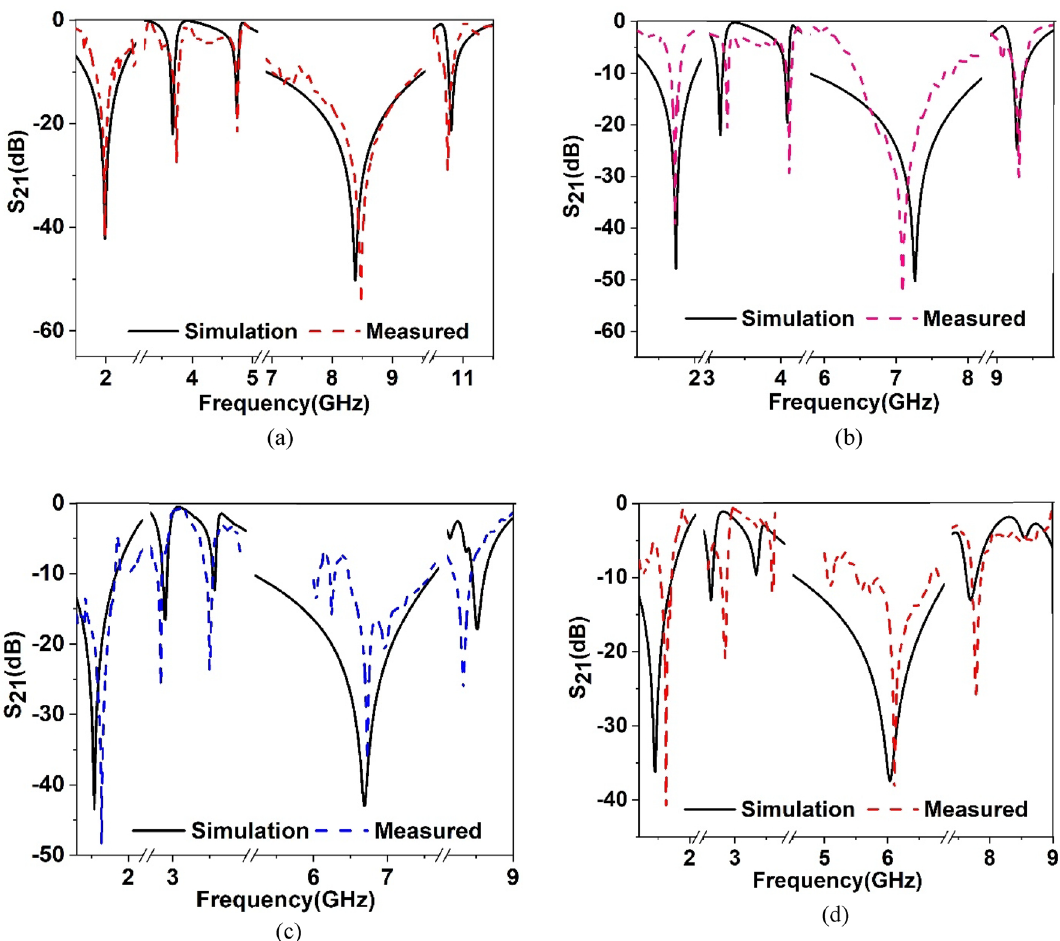
Figure 14. Measured transmission coefficient(S 21 ) of the proposed MTM without and with dielectric layer: ( a ) MTM without dielectric layer, ( b ) with Rogers(RT5880) layer, ( c ) with polycarbonate layer, ( d ) with FR4 layer.